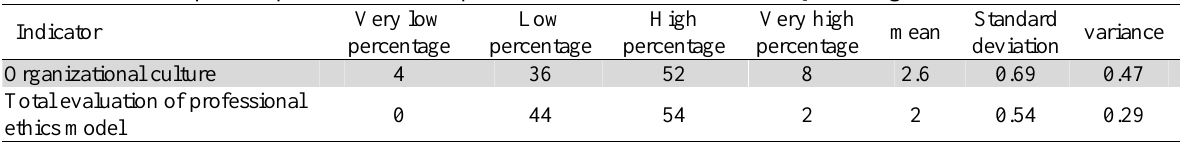
Distribution of repliers' opinions about the professional ethics indicators in Qom religious research centers Indicator